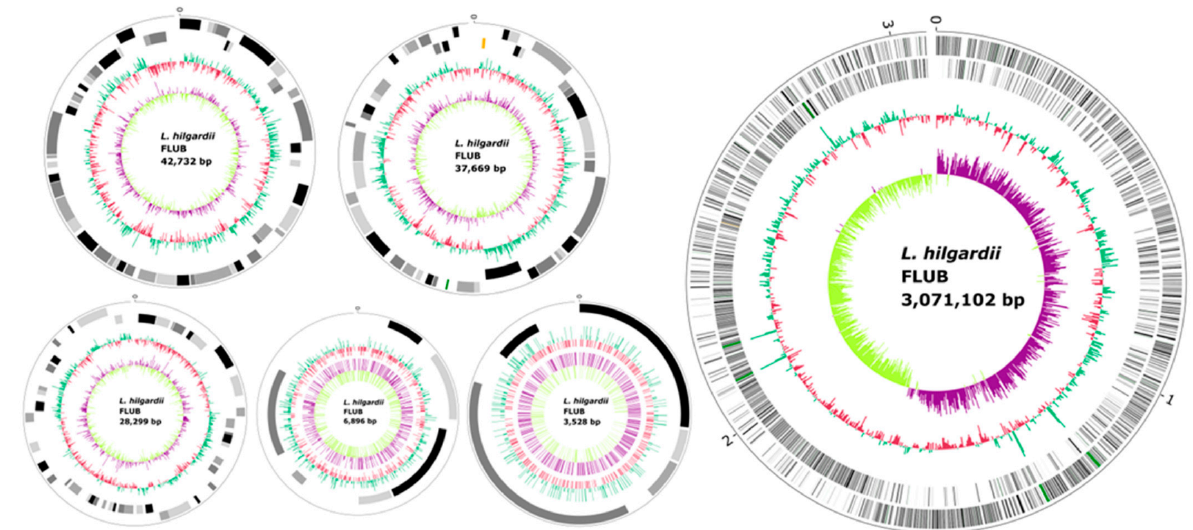
Figure 4. Circular map of the L. hilgardii FLUB chromosome and plasmids. The outer circle shows the scale in megabases (Mb). The representation, from outer to inner circle, is as follows: forward and reverse strand CDSs (the color gradient represents the percentage of GC; the green stripes represent RNAs genes), GC content, and GC skew. The genome map was visualized using the CGView circular genome visualization